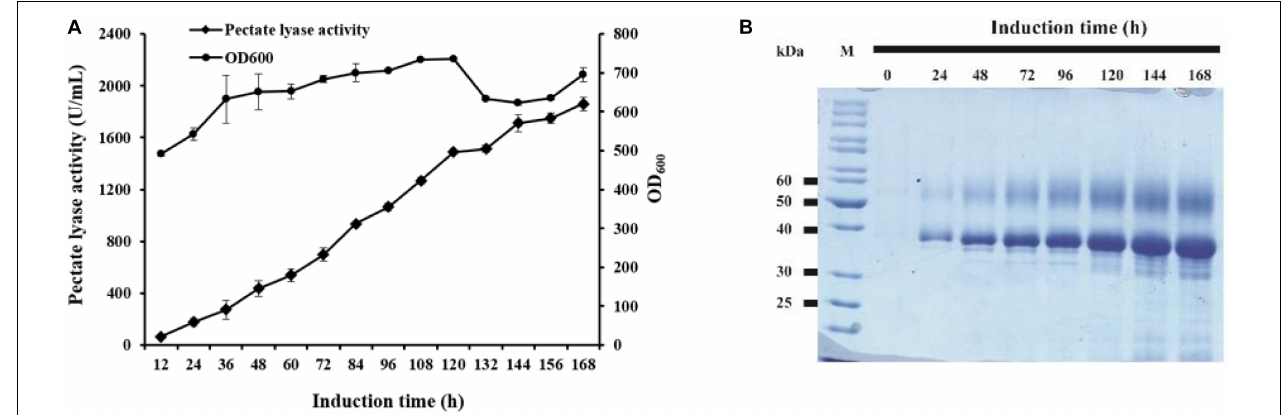
FIGURE 3 | The time course of recombinant enzyme production in a 50 L fermentator and SDS-PAGE analysis. (A) Time dependence of the activity of pectate lyase and cell growth of GS115/pAmNS-4BspPel after induction with methanol, using GS115/HKA as the background (control) sample; (B) SDS-PAGE assay of the collected culture supernatant from the most effective strains in the fermentator after 168 h of induction with methanol. Lane M: protein marker; lane 1–lane 8: recombinant protein expression from 0 to 168 h.